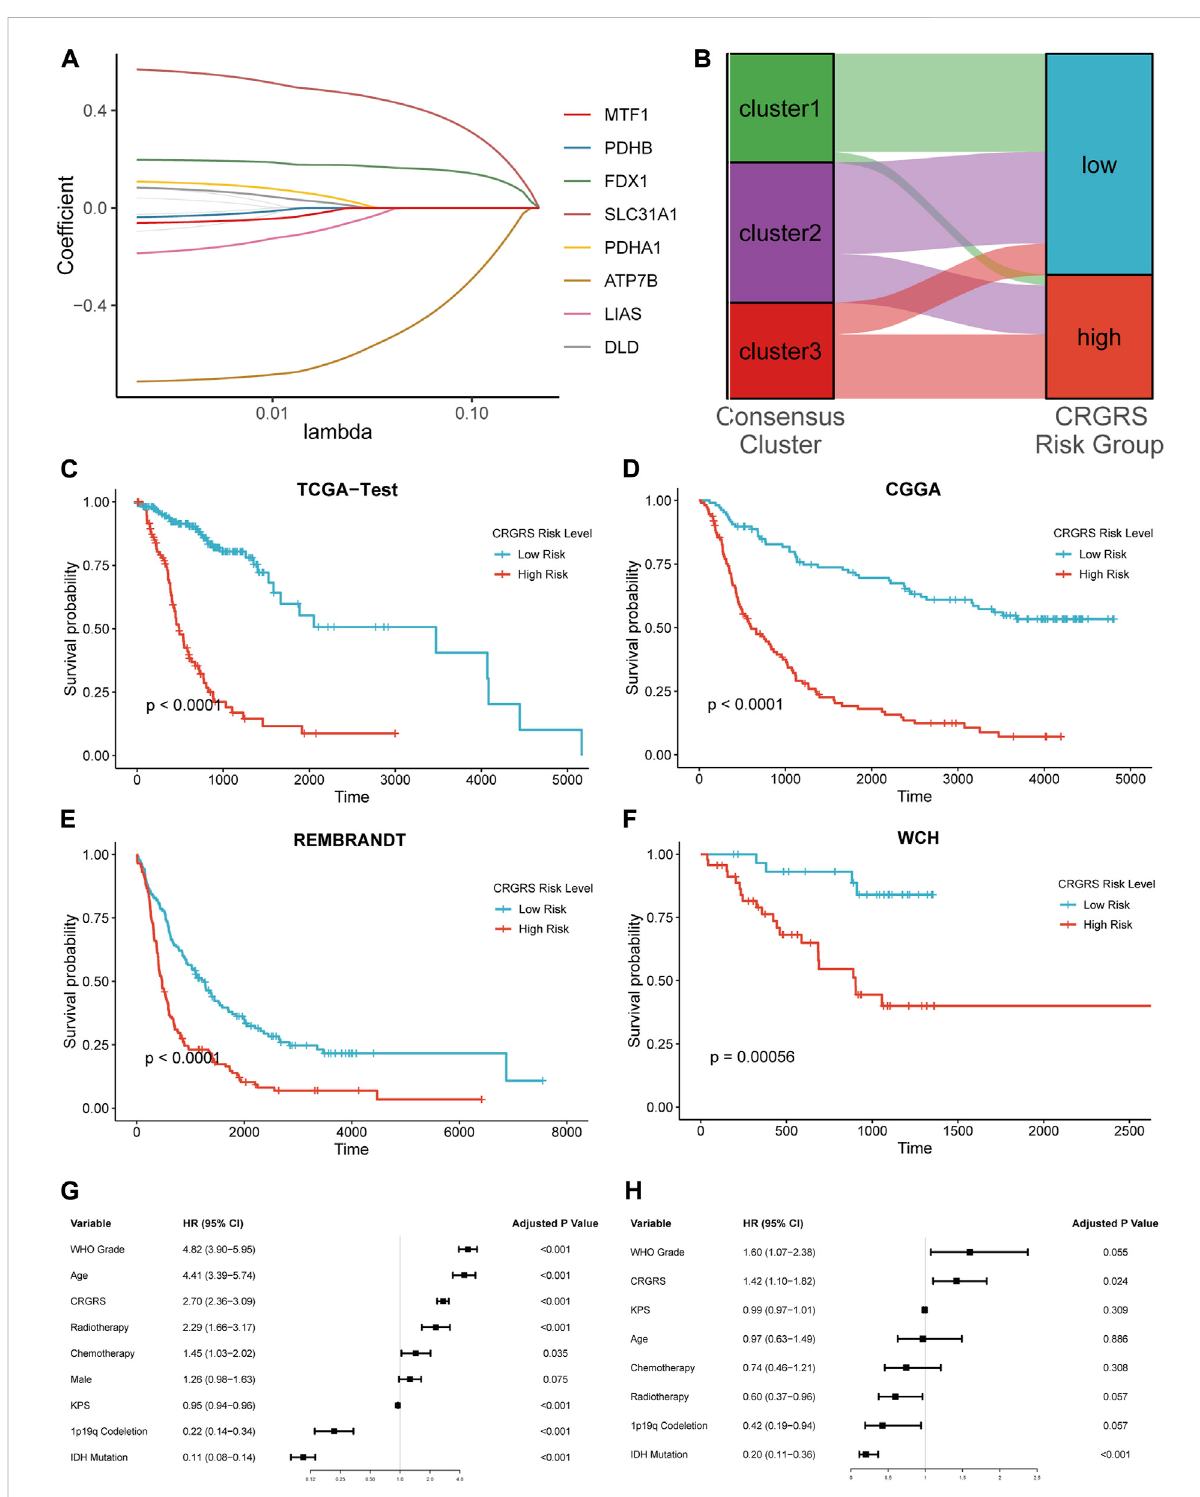
FIGURE 6 Expressionsignatureofcuproptosis-relatedgenesanditsrelationshipwithprognosis. (A) Averageofcoef fi cientsof7criticalCRGsintheLASSO Cox regression at each lambda value. (B) The relationship between the consensus clusters and two CRGRS risk groups. (C) K-M curve of the TCGA test set, cut off = 0.19. (D) K-M curve of the CGGA cohort, cut off = 0.39. (E) K-M curve of the REMBRANDT cohort, cut off = -9.64. (F) K-M curve of theWCHcohort,cutoff=-0.056. (G) Univariateand (H) MultivariateCoxregressionanalysisofpotentialprognosticfactorsinoverallsurvivalof